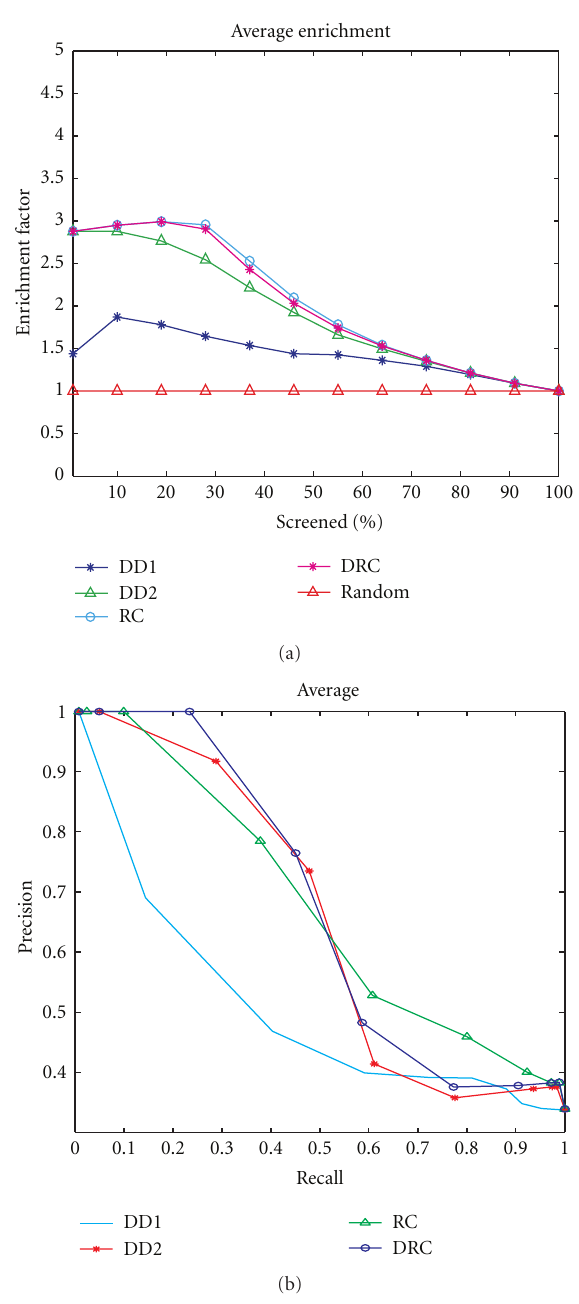
Figure 6: Ranking and retrieval performance for the proposed methods. (a) Enrichment plot for screening protein structures using the proposed descriptors. Results are average for 5 query proteins from cell division protein kinase 2 family (Group 3), using DATASET-A (416 protein chains). (b) Average precision and recall for three queries, one for each group in DATASET-A. DD1 corre- sponds to the distance distribution proposed in [11], as described in Section 2 (see Section 4.5 on comparison with related